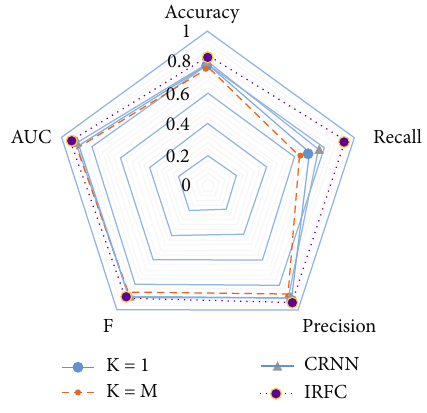
Figure 6: Student skill evaluation scores.